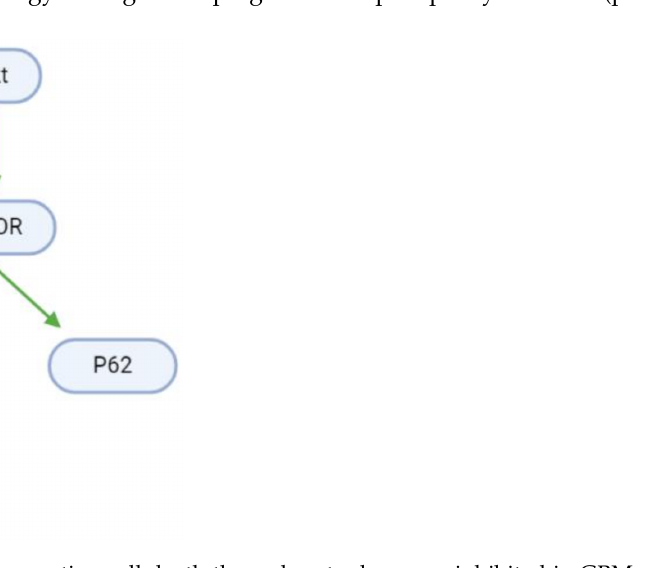
Figure 6. Pathways promoting cell death through autophagy are inhibited in GBM cells. mTOR inactivates the pro-autophagy Beclin-1 and upregulates the anti-autophagy P62. Table 5. Arctigenin and osthole promote autophagy by upregulating Beclin-1 and LC3B-II and downregulating